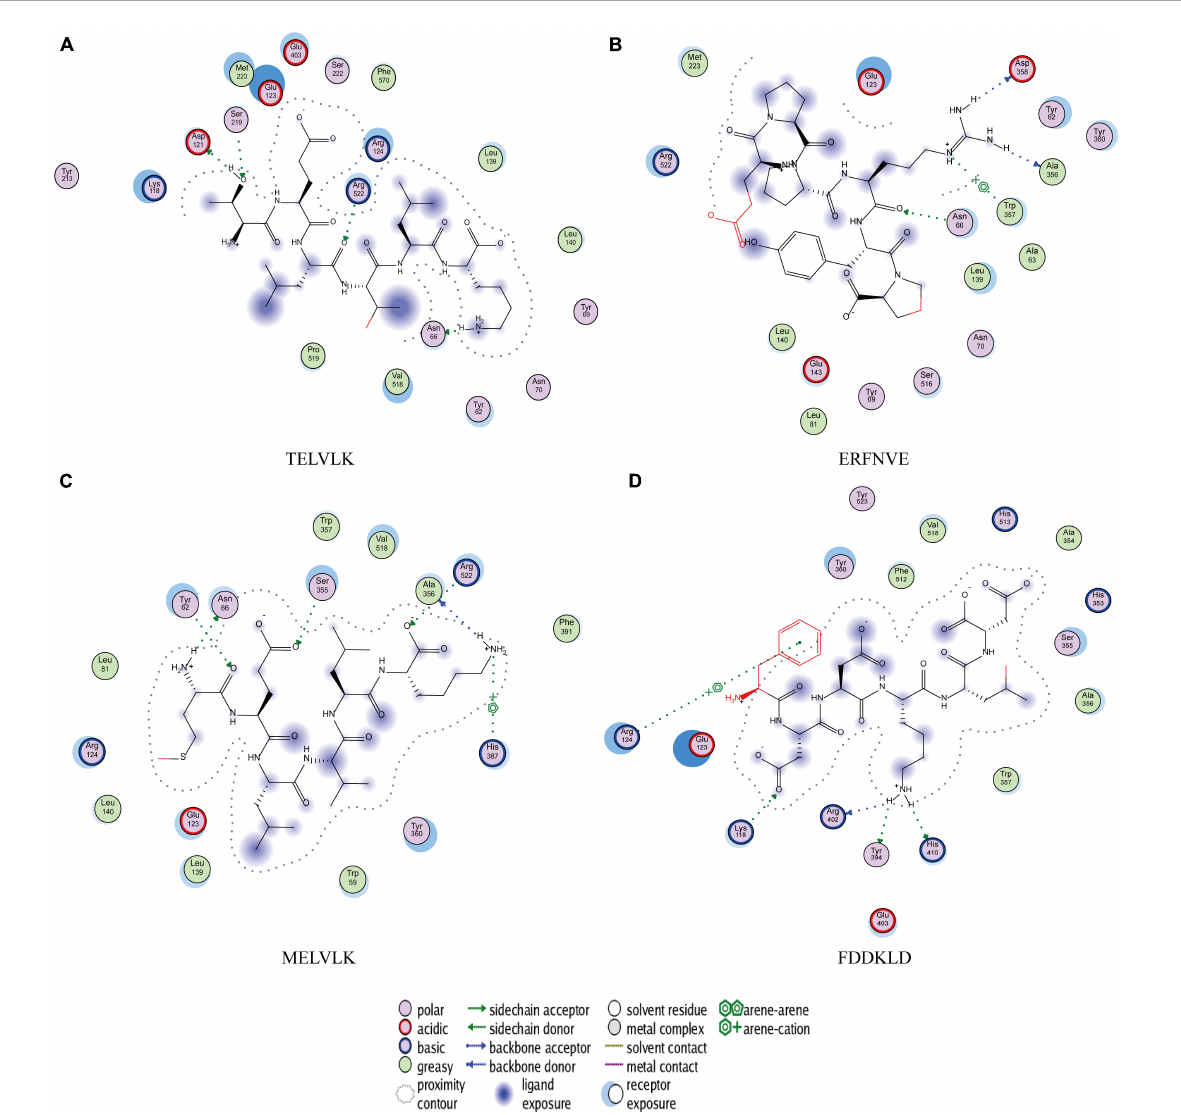
FIGURE7 Molecular docking results of (A) TELVLK; (B) ERFNVE; (C) MELVLK; (D) FDDKLD, 2D structures of the peptides illustrating the poses for the binding of the peptides to the molecular surface of